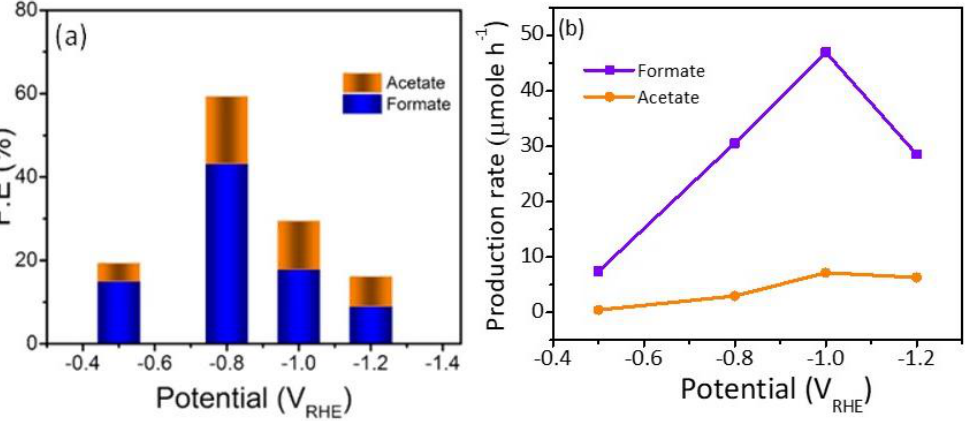
Figure 9. ( a ) FEs. ( b ) Production rate of the liquid products by Cu/NC-700 at the function of poten- tial. Table 1. Comparison of the catalytic performances of Cu/NC-700 and the similar electrocatalysts reported in literature for the reduction of CO 2 to liquid products.